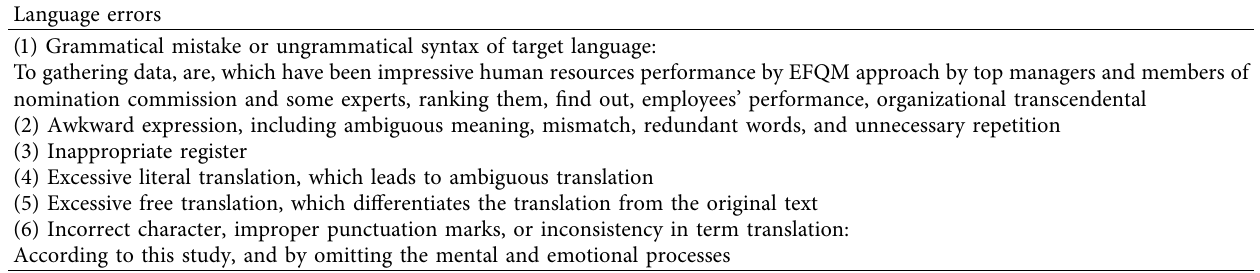
Table 5: Language errors related to sample